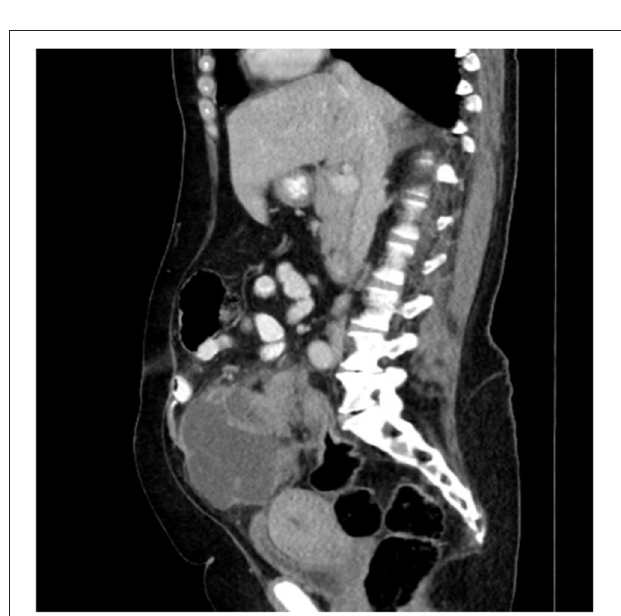
FIGURE 1 | Axial CT with mass measuring ∼ 11cm × 10 cm.